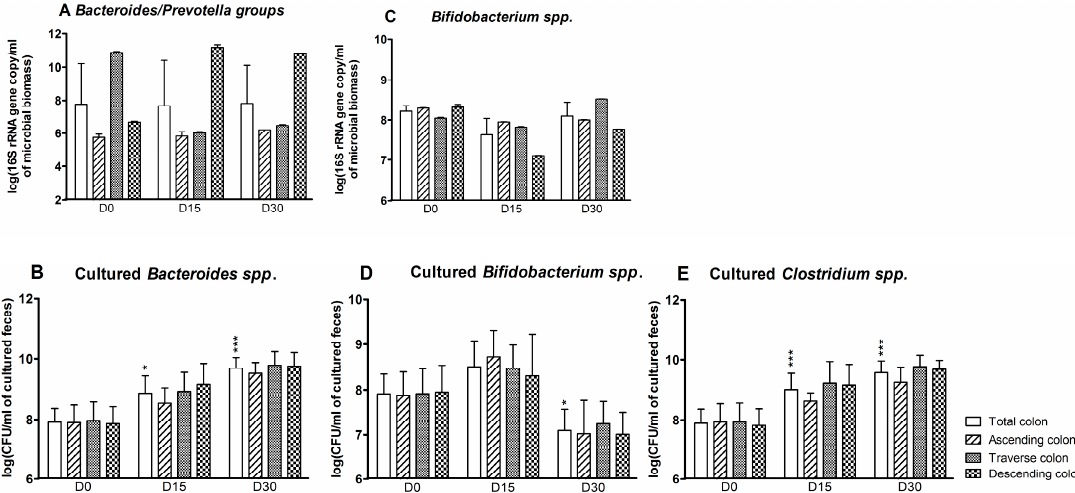
Figure 2. Anaerobe counts for the SHIME ® ’s colon as a whole and for each of the individual colon reactors at the end of the control period (D0) and after 15 and 30 days of exposure to CPF 1 mg/day in oil (D15 and D30). ( A ) Bacteroides/Prevotella groups determined by qPCR (log 16S rRNA gene copy/mL of microbioal biomass); ( B ) cultured Bacteroides spp . counts (log CFU/mL of cultured feces); ( C ) bifidobacterial counts determined by qPCR (log 16S rRNA gene copy/mL of microbioal biomass); ( D ) cultured bifidobacterial counts (log CFU/mL of cultured feces); and ( E ) cultured Clostridium spp . counts (log CFU/mL of cultured feces). Data are expressed as the mean ± SD and were analyzed in a Kruskal Wallis test and then a Mann Whitney test. The level of statistical significance is indicated as follows: * p < 0.05; *** p < 0.001.